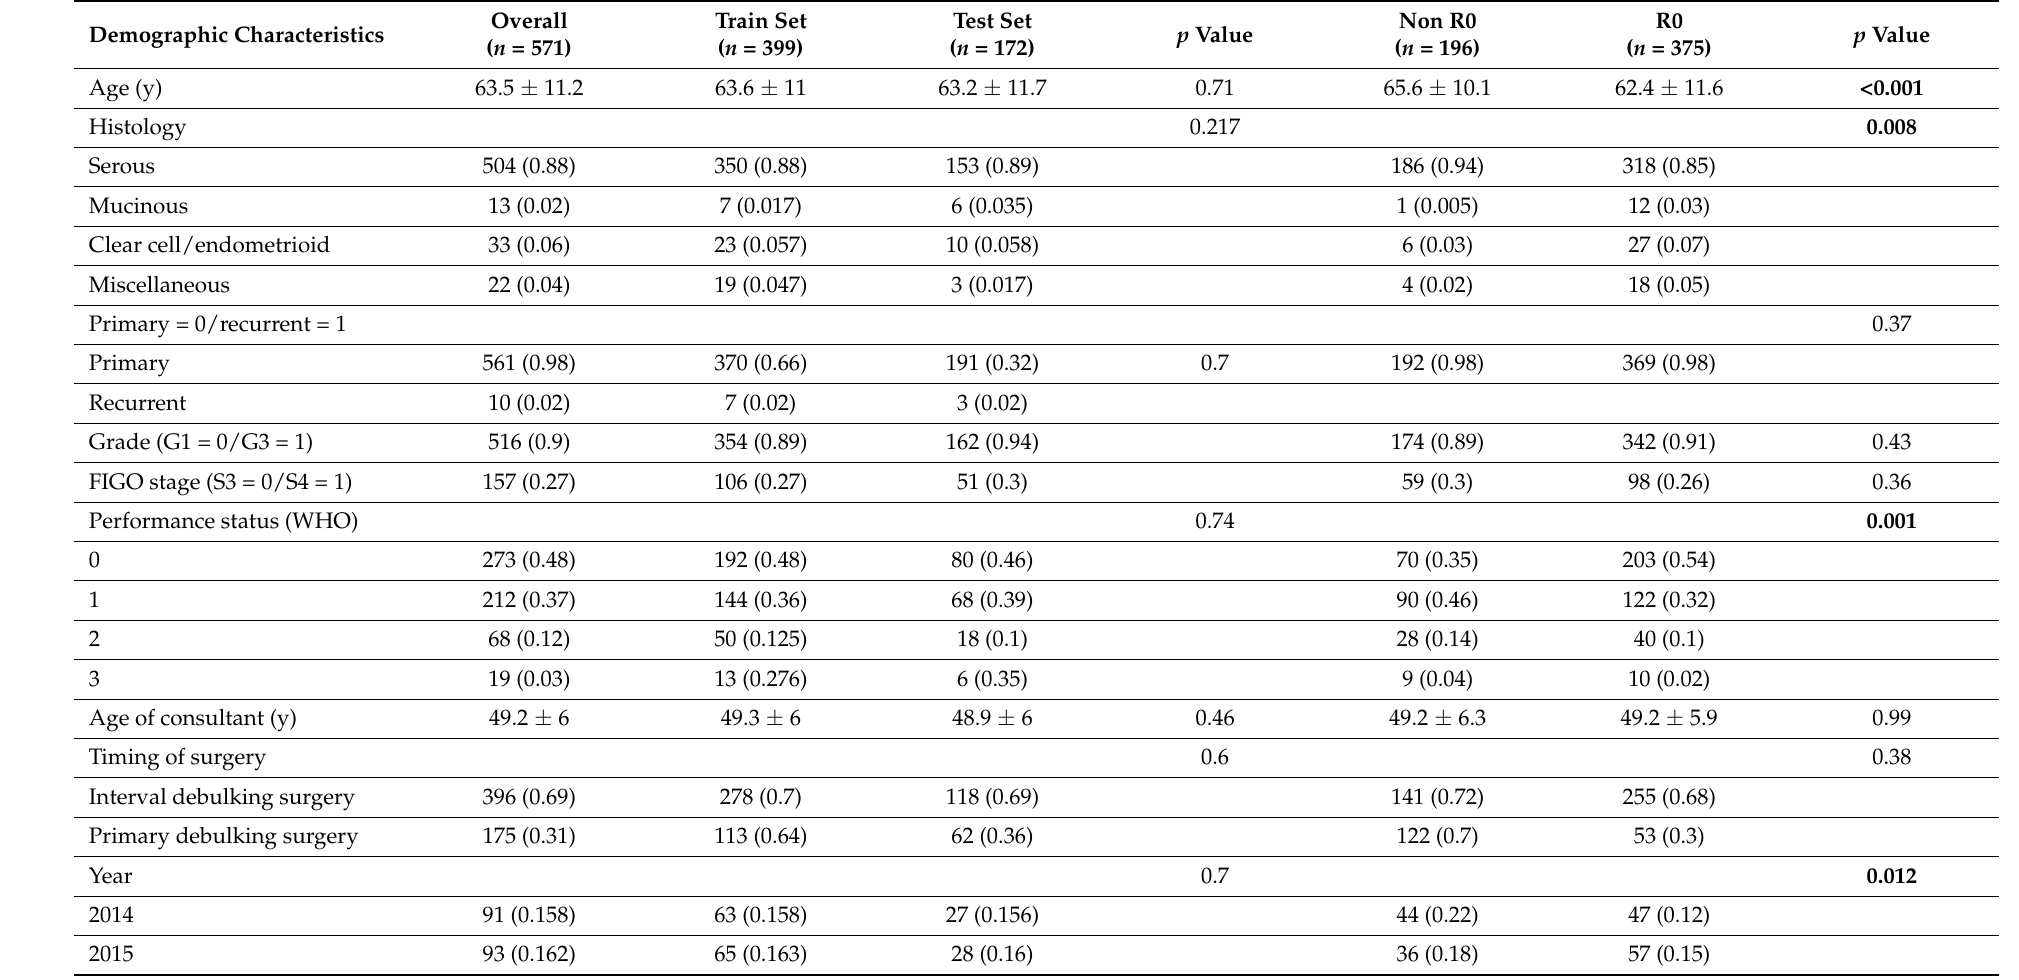
Table 1. Cohort descriptive statistics: values are mean ± SD or n